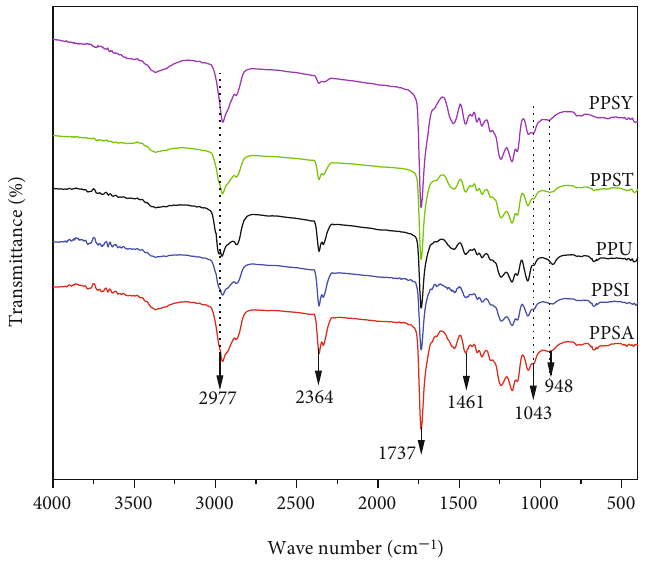
Figure 1: FTIR spectrum of the